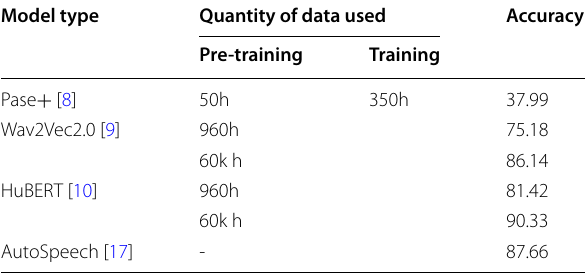
Table 4 SOTA results over VoxCeleb1 and quantity of data